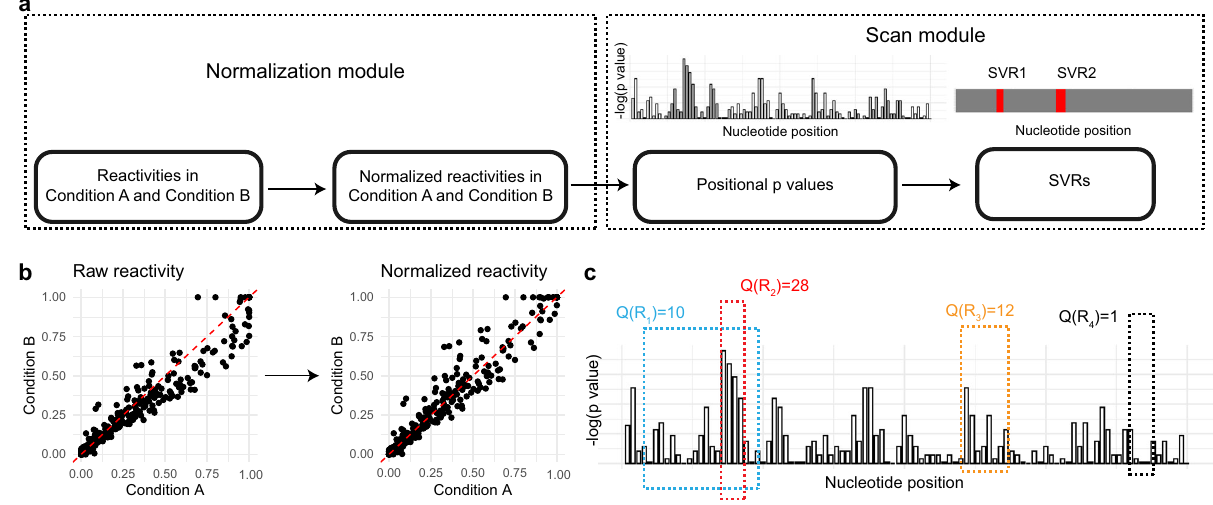
Fig. 1 Work fl ow of DiffScan. a Taking raw reactivities as input, DiffScan fi rst normalizes them relative to one another in the Normalization module (b) to correct for systematic bias, and then identi fi es SVRs in the Scan module (c). b The Normalization module transforms raw reactivities into normalized reactivities to remove systematic bias. The raw reactivities are from the icSHAPE SRP vivo dataset which has no SVRs. The normalized reactivities are comparable as far as possible across different cellular conditions. c Taking normalized reactivities as input, the Scan module fi rst calculates the signi fi cance of any differential signals for each nucleotide position with two-sided Wilcoxon test, and then concatenates positional p values into a regional signal via scan statistic. The signi fi cance of the scan statistic for each enumerated region is evaluated by Monto Carlo sampling, and those regions crossing a speci fi ed signi fi cance threshold are reported as